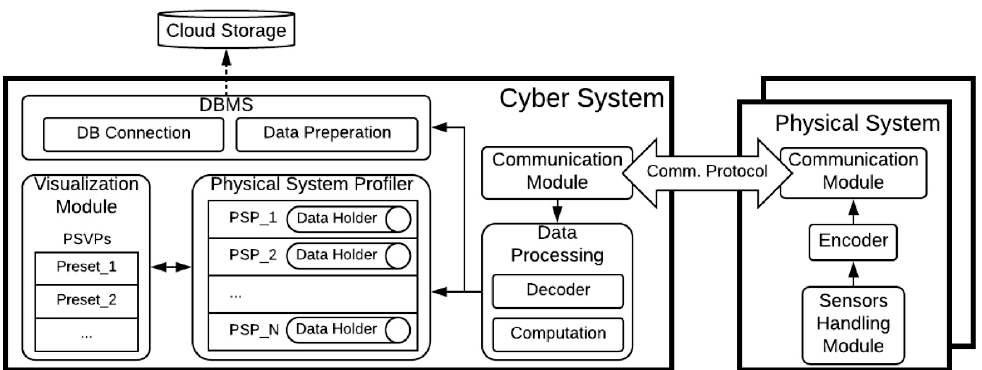
Figure 1. Proposed Cyber-Physical Systems (CPS) framework main components include one or more physical systems, a cyber system, and a well-defined communication protocol. DMBS: Database Management System; DB: Database; PSVPs: pre-coded physical system visualization presets.